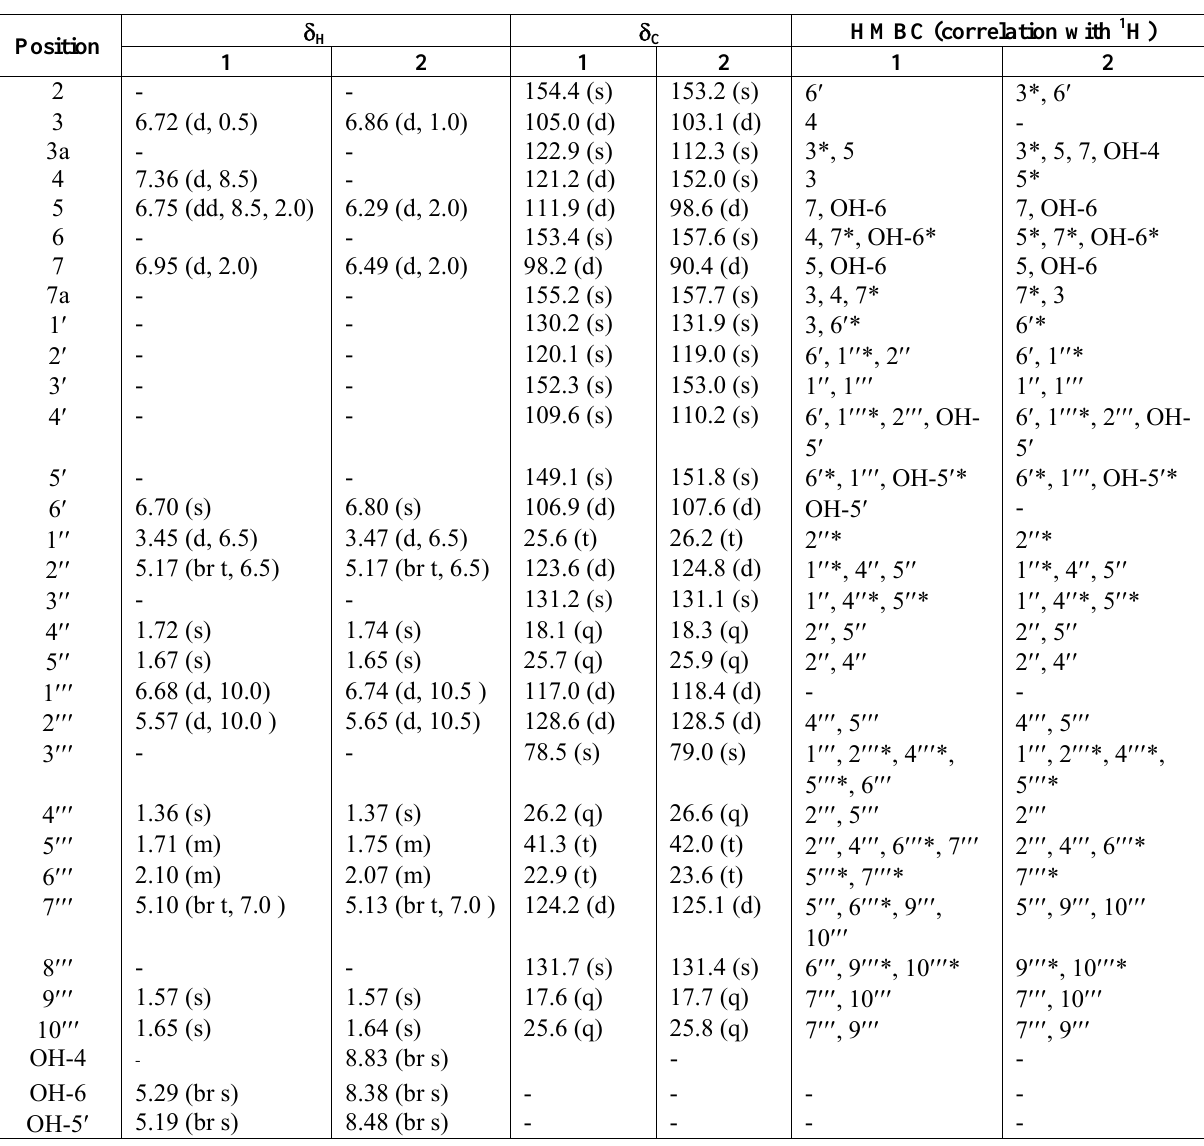
) and 2 (acetone- d 3